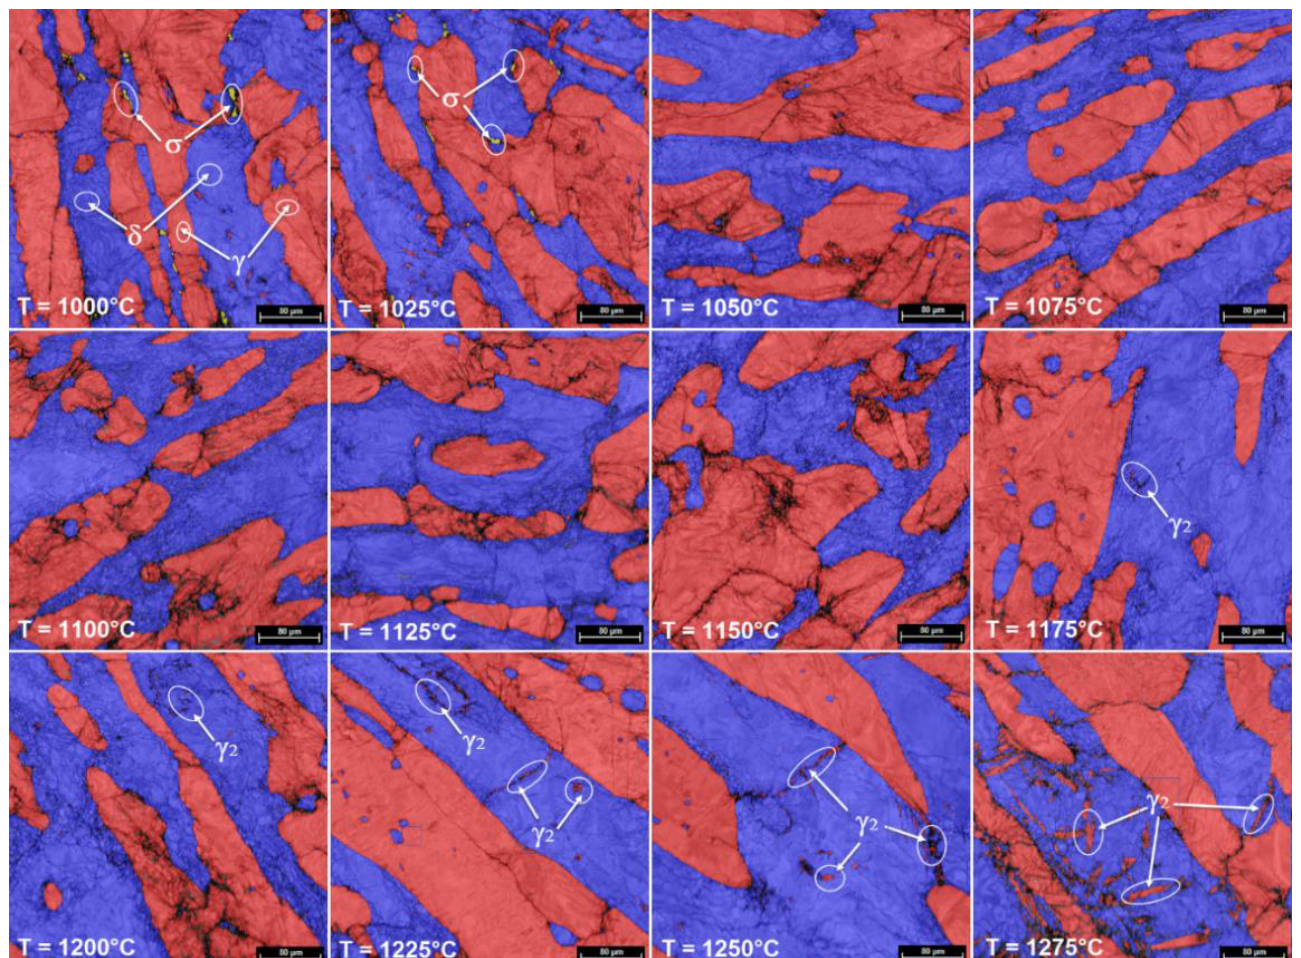
Figure 5. SEM-EBSD images showing typical constituent phase distribution maps in hot-deformed UNS S32750 SDSS alloy (from 1000 °C to 1275 °C).